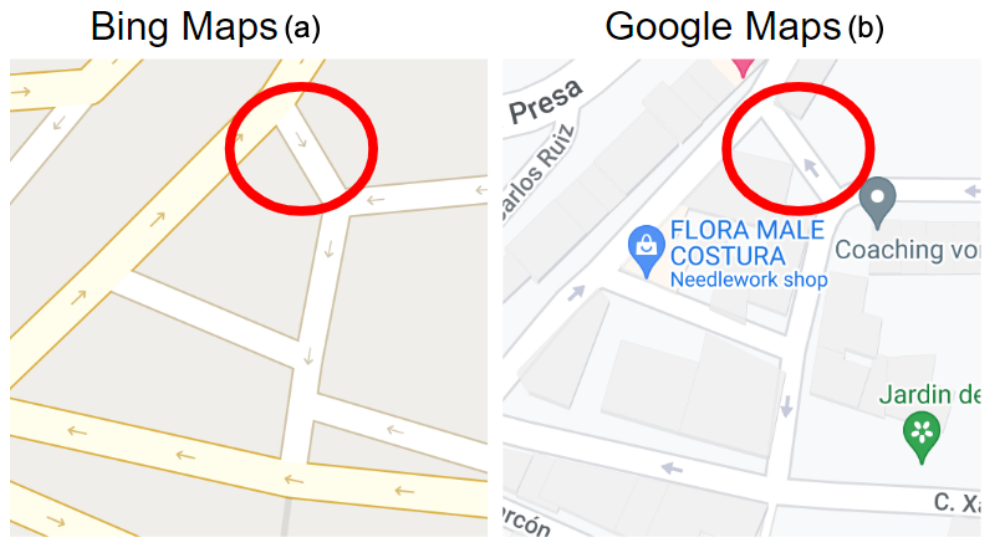
Figure 1. Discrepancy example of road directionality across different providers: ( a ) Bing Maps shows this road in Spain heading southeast; ( b ) Google Maps, however, shows this same road heading